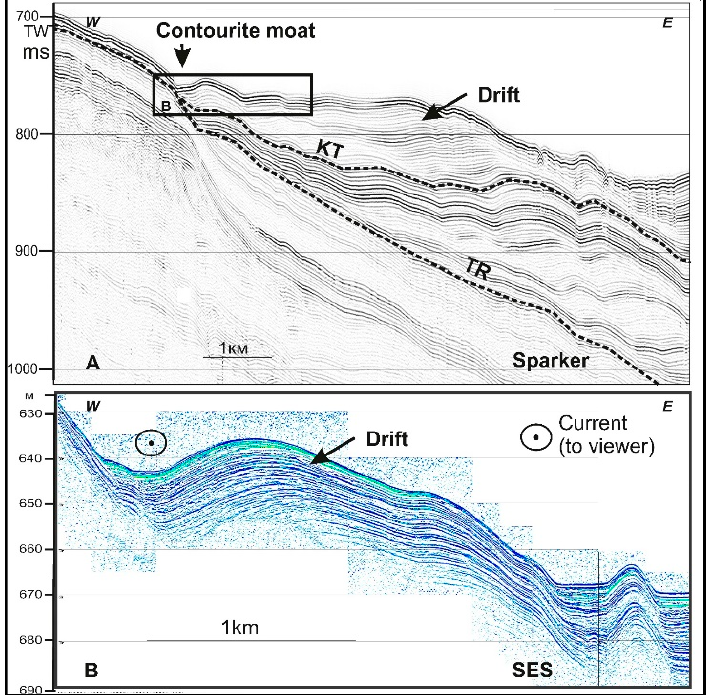
Figure 6. Separated drift in the contourite mounded elongate drift at the foot of the western slope of the Derbent Basin. ( A ) Fragment of the profile (sparker) from Figure 4A. Main unconformities: TR –Turkanian regression, KT—Khvalinian transgression. ( B ) Enlarged fragment of ultra-high-resolution seismic reflection profile (SES) showing in detail uppermost sedimentary layer with a migration drift dome and adjacent erosional moat. Current in moat is to the viewer.